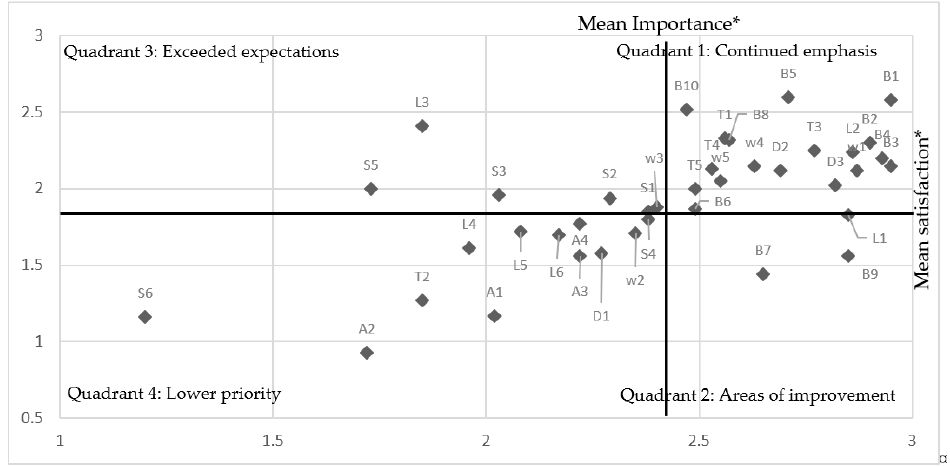
Figure 5. I-S analysis of the place quality. Note: The reference of importance and satisfaction in Figure 5 was the mean of “3 = important/satisfied” given by respondents to the survey.